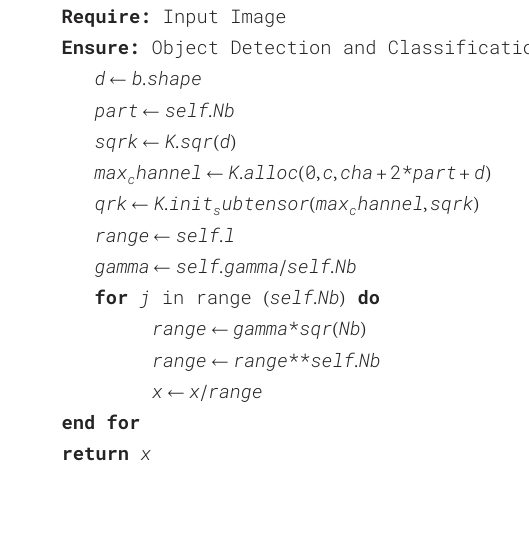
Algorithm3. GoogleNetClassifier.